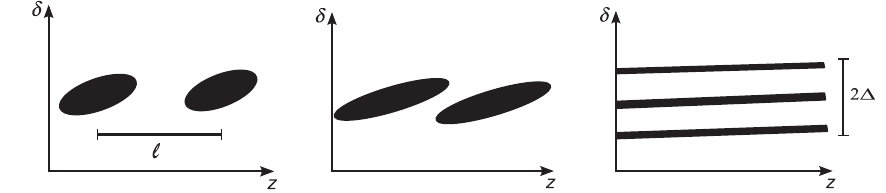
FIG. 5. Debunching of microbunches and subsequent formation of filaments. l is the distance between the microbunches and (cid:2) (cid:2) 2 (cid:10) the momentum spread of the debunched p